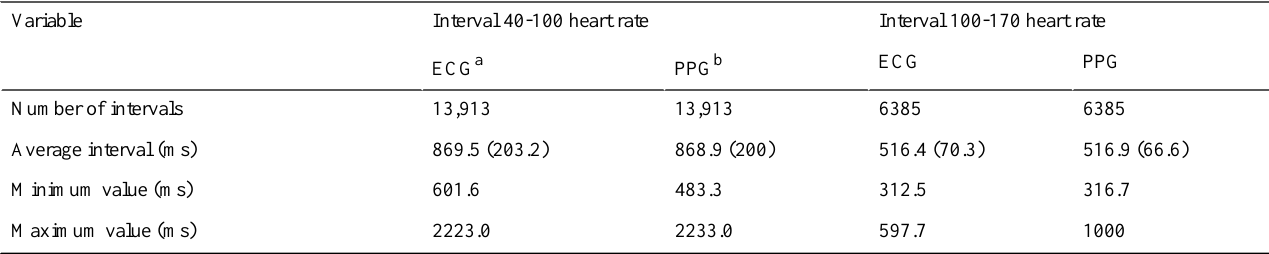
Table 6. Summary of intervals divided in low, high, and overall heart